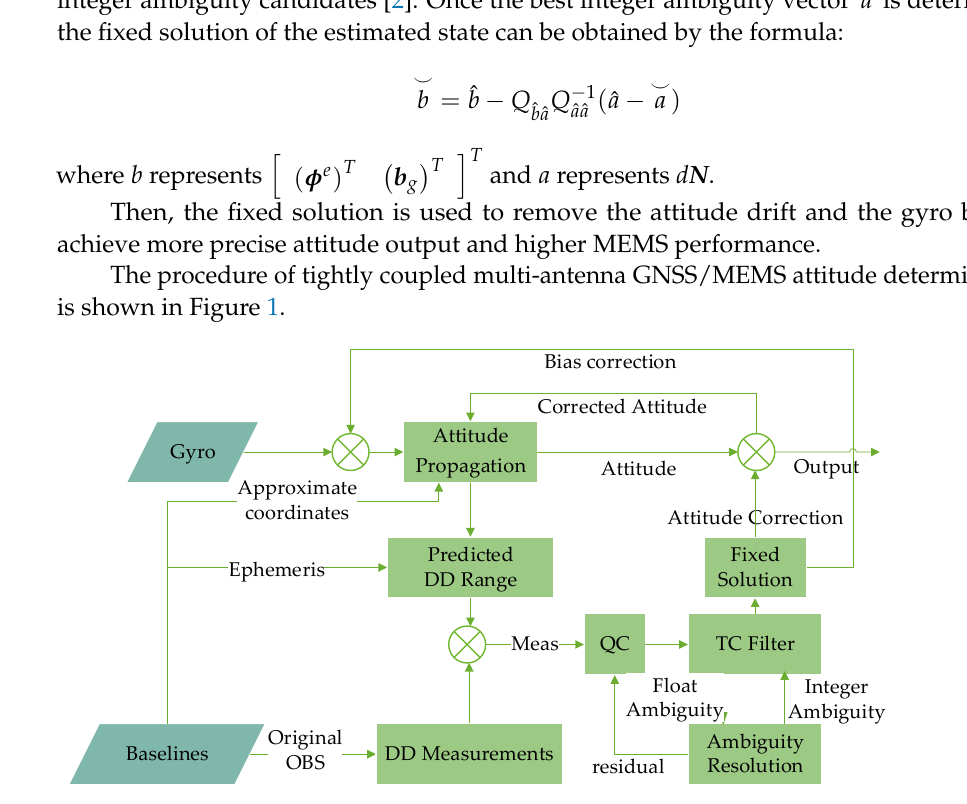
Figure 1. Flow chart of tightly coupled attitude determination.